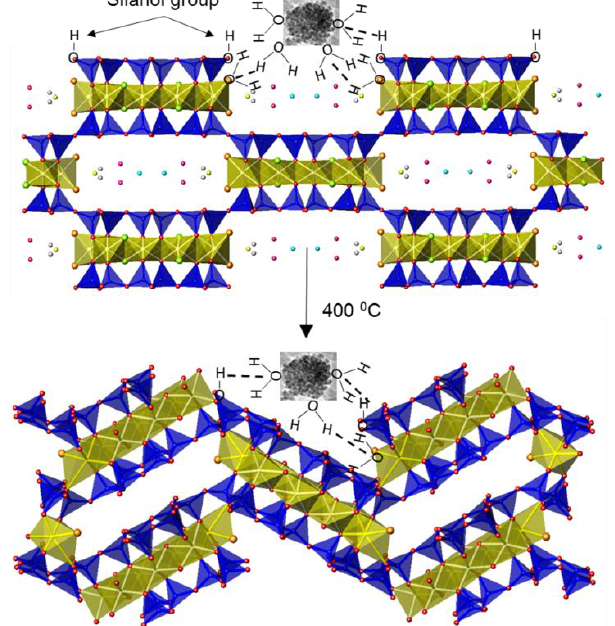
Figure 11. Schematic representation of the interaction between iron oxide nanoparticles and sepiolite surface via hydrogen bonds, in the FO-Sep@C-400